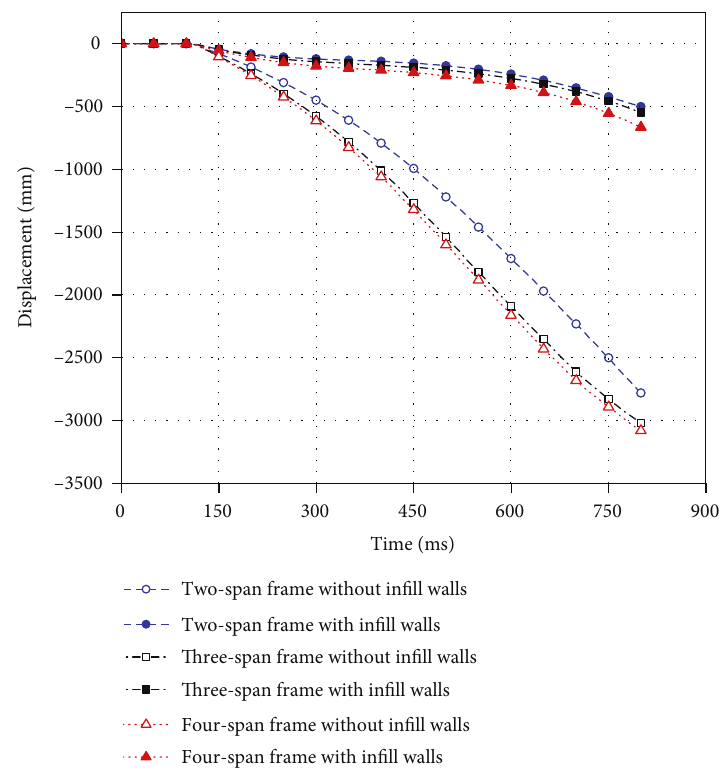
Figure 16: The z -directional displacement at the apex of the three-story side column after damage.